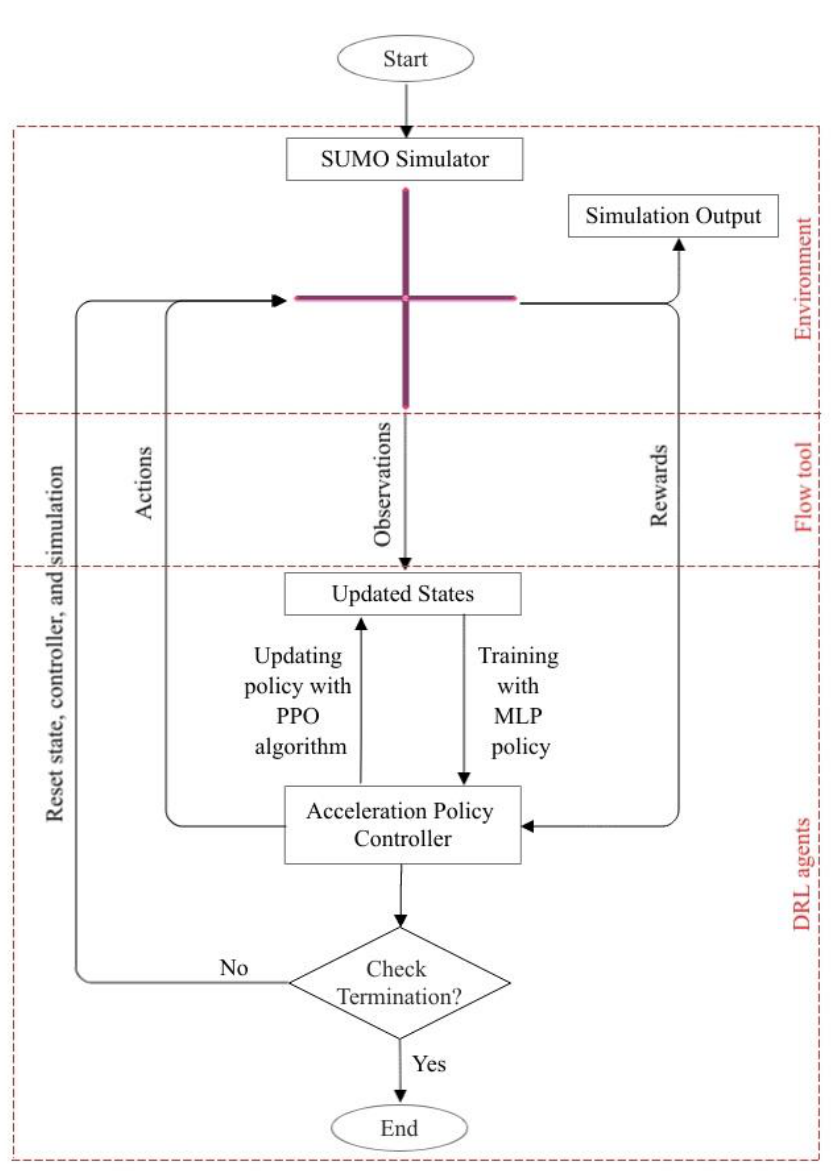
Figure 1. The research proposal flow architecture.